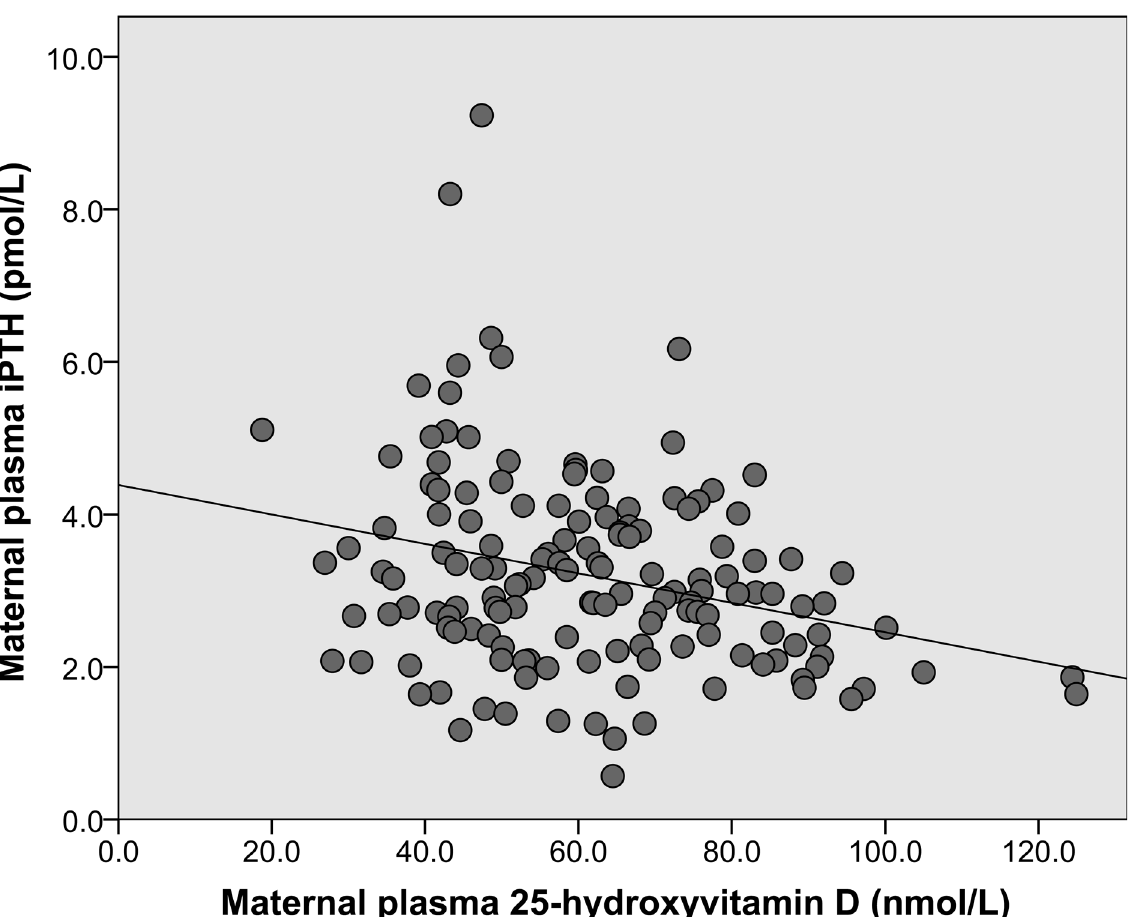
Fig 1. Scatter plot showing the relationship between maternal intact parathyroid hormone and 25-hydroxyvitamin D level. The maternal plasma level of 25-hydroxyvitamin D [25(OH)D]showed a weakly negative correlation with the maternal plasma level of intact parathyroid hormone (iPTH), n = 147. Linear regression equation: iPTH = – 0.0193[25(OH)D] + 4.3884. (Pearson ’ s r = – 0.29, P <